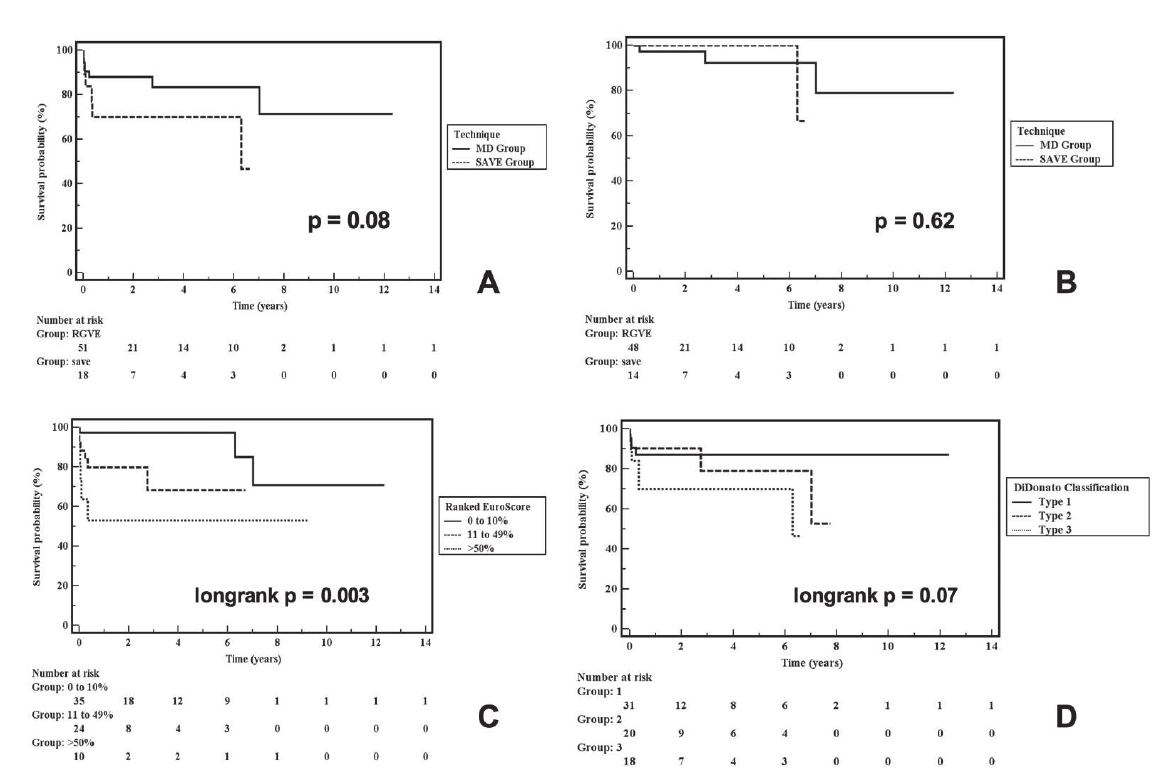
Fig. 2 - (A) Survival curve with all mortality for the two different surgical techniques. (B) Survival curve without operative mortality for the two different surgical techniques. (C) Survival curve with all mortality cases ranked by EuroScore. (D) Survival curve with all mortality cases with Di Donato left ventricle